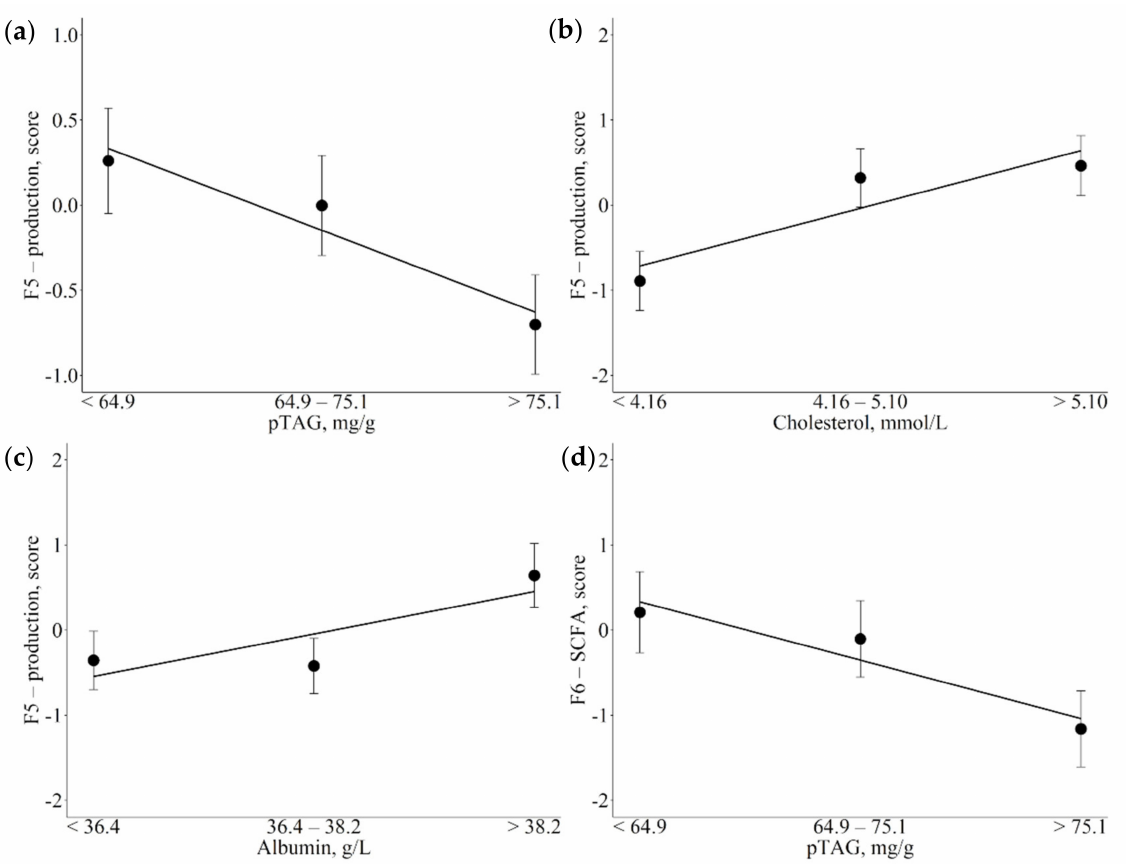
Figure 3. Least square means (LSM) for F5-production ( a , b , c ) and F6-short chain fatty acids (SCFA; ( d )) across the traits of concern. ( a , d ): predicted liver triacylglycerol (pTAG); ( b ): cholesterol; ( c ): albu- min. Black dots indicate the LSM and error bars indicate the standard error. Trendlines define linear or quadratic pattern according to polynomial contrast calculations ( p <